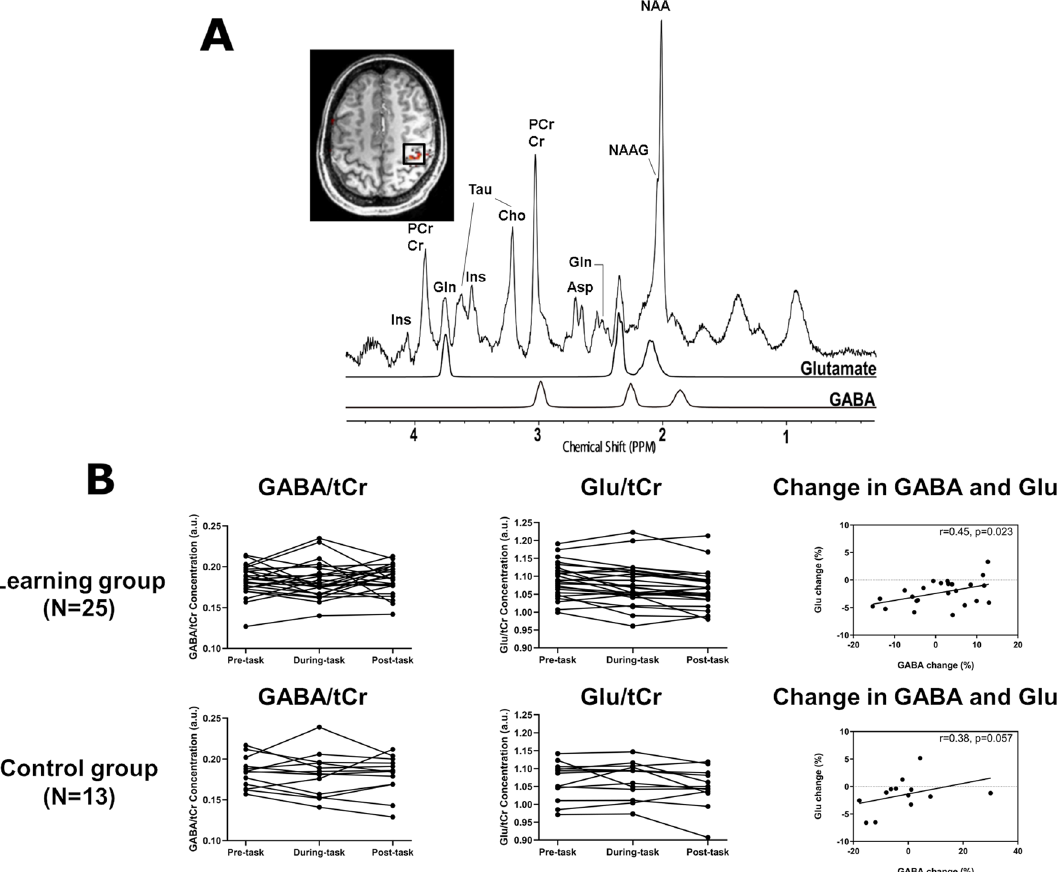
Figure 2. Magnetic resonance spectra and neurotransmitter levels. ( A ) MR spectra of the right primary motor cortex (M1) acquired in one subject (STEAM, TR/TE = 5000/5.68 ms; mixing time = 40 ms; vector size = 2048; bandwidth = 4000 Hz/Px; average = 64), as well as LCModel spectra fit for Glutamate and GABA are shown. The 2 × 2 × 2 cm 3 volume of interest (black square) is centered over the hand knob area of M1 identified using fMRI during a finger opposition task (red) and is superimposed on the T1w MPRAGE image. Cho, choline; Cr, creatine; PCr, phosphocreatine; Gln, glutamine; Glutamate, Ins, myo-inositol; NAA, N-acetylaspartate; NAAG, N-acetylaspartylglutamate; Asp, aspartateaspartate; Tau, taurine. ( B ) Task-related changes in GABA and Glutamate (Glu) levels. The left and middle columns indicate the concentrations of GABA and Glu within the right M1 during the pre-task, during-task, and post-task of Learning Group (Top) and those of Control Group (Bottom). The right column show the association between GABA and Glu changes post motor sequence learning task of the Learning Group (Top) and Control Groups